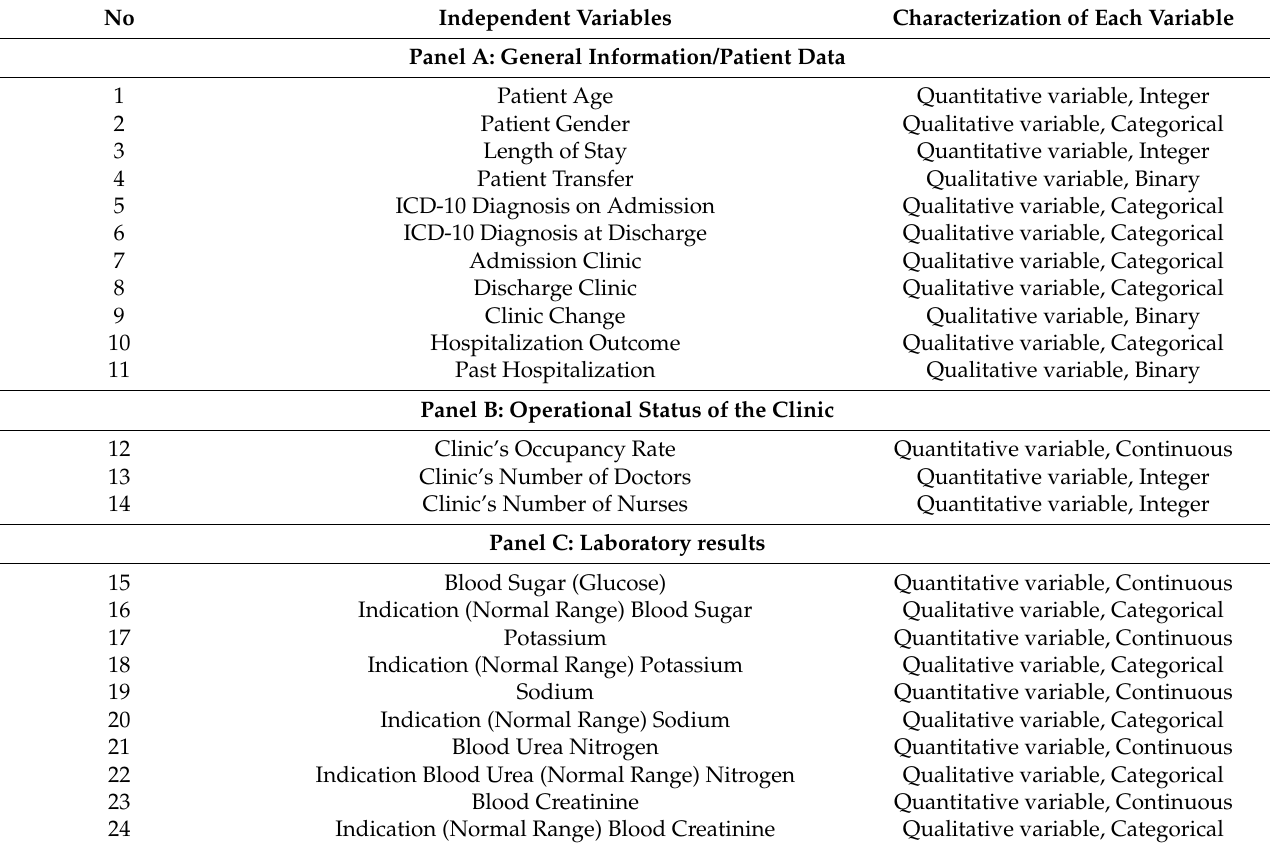
Table 1. Input Variables of the